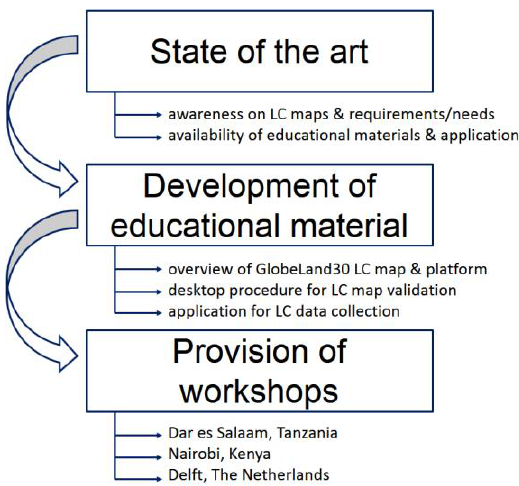
Figure 1. Workflow of the project “Capacity Building for High- Resolution Land Cover Intercomparison and